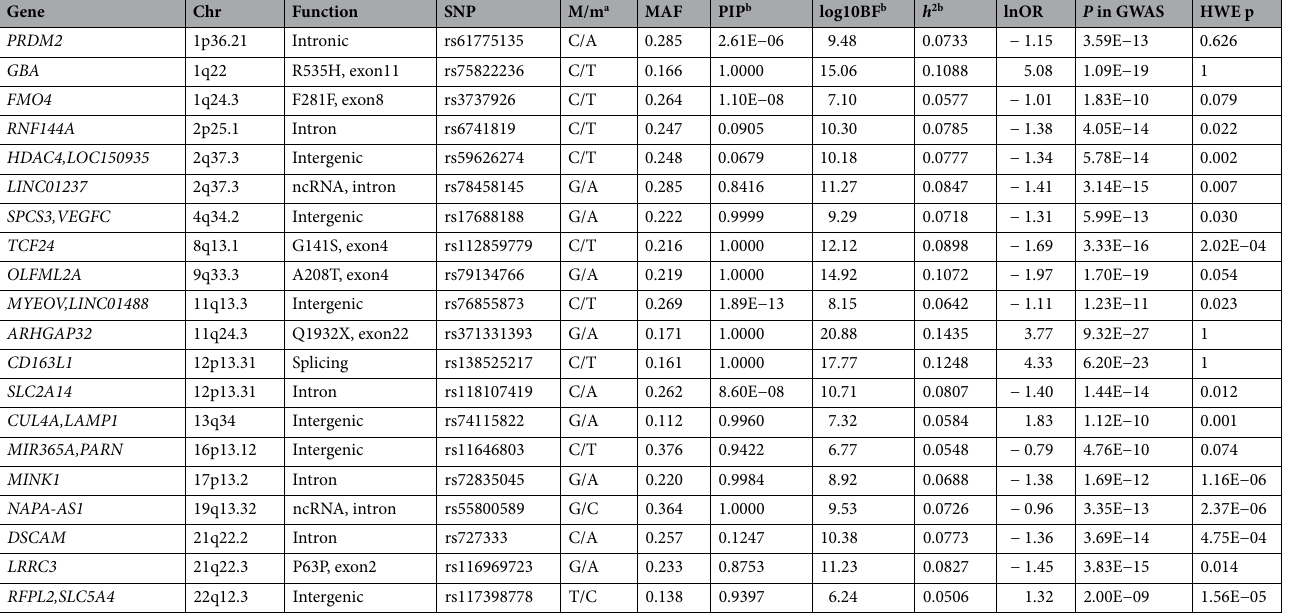
Table 1. Significant candidate loci identified by fine-mapping after genome-wide association study. GWAS genome-wide association study, log10BF log10 transformed Bayes factor, lnOR natural log-transformed odds ratio, PIP posterior inclusion probability, MAF minor allele frequency. a M/m indicates major/minor allele type, respectively. b PIP, log10BF, and heritability ( h 2 ) of individual variants were estimated via FINEMAP program to identify possible susceptibility to intracranial aneurysm (IA). c lnOR and P -value were estimated by IA